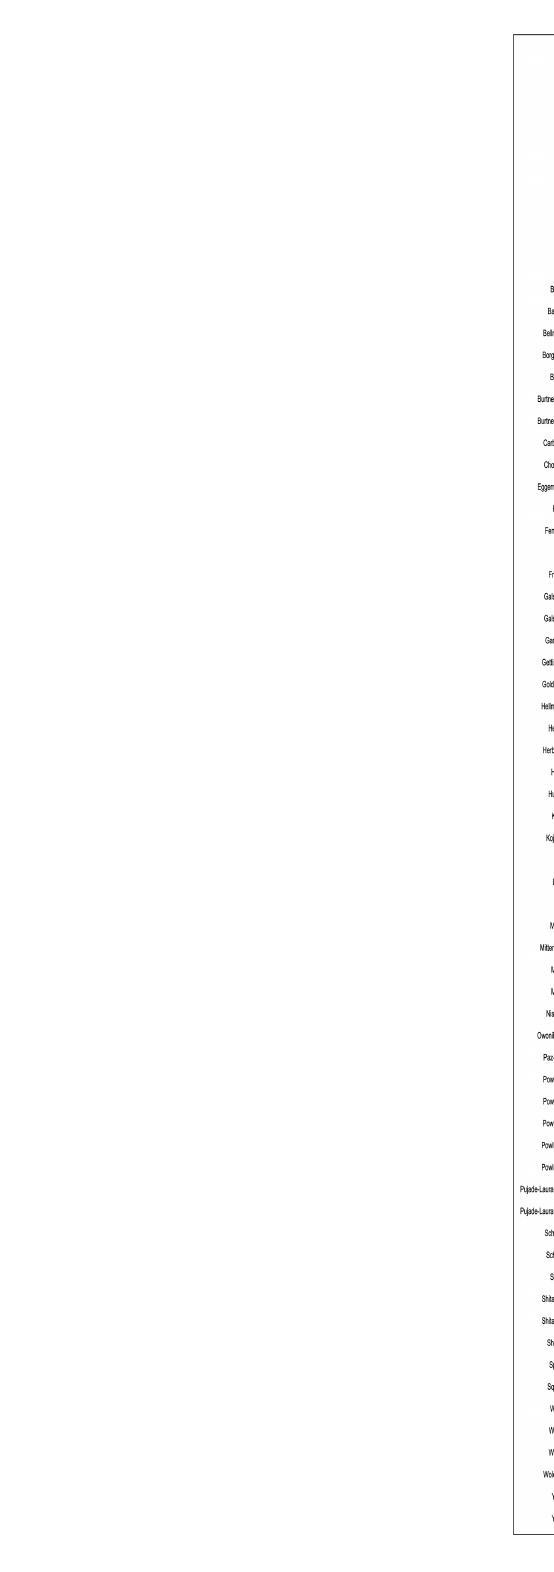
FIGURE 2 | Risk bias